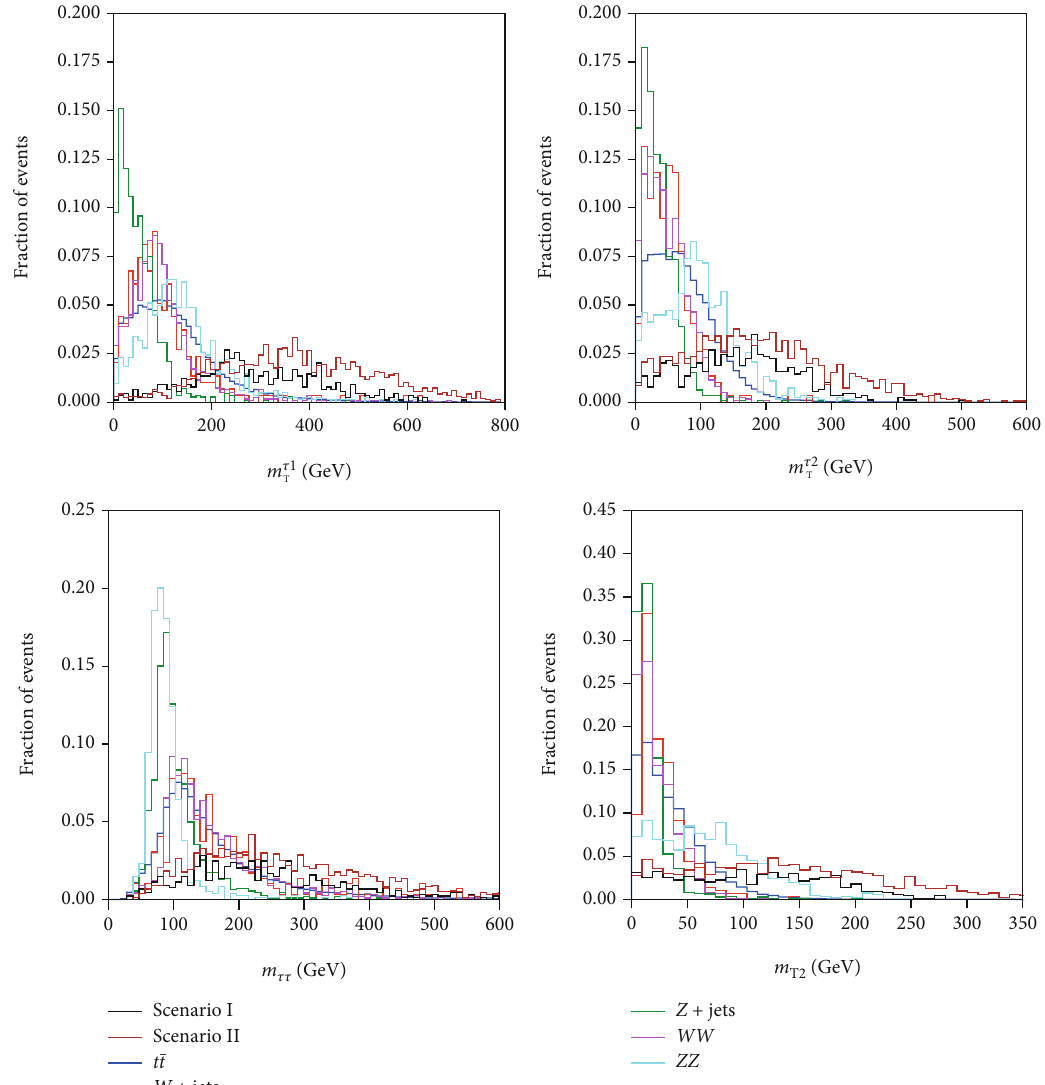
Figure 1: Four di ff erent distributions of kinematic variables after the selection cuts are applied to the signal and background events. On each case, we show the distribution of the signal for the two scenarios along with those corresponding to the backgrounds listed in Table 2. (a) Transverse mass of the leading tau lepton, m leptons, m ττ . (d) Stransverse mass m